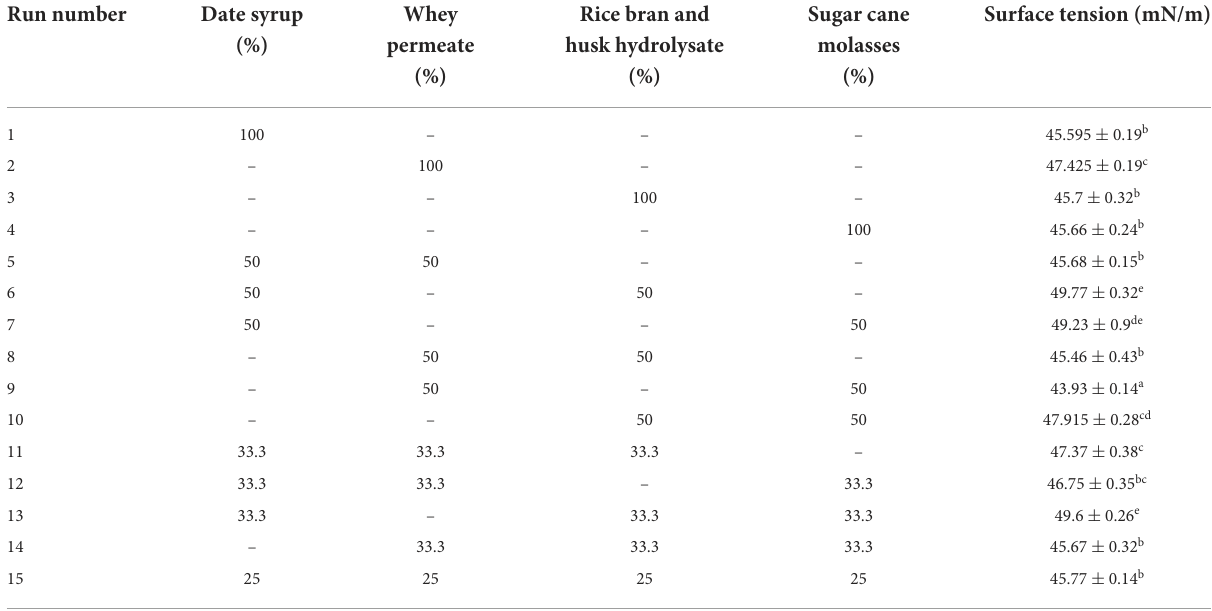
TABLE 2 The percentage of waste materials in each run and surface tension activity of L. plantarum -derived biosurfactant. Run